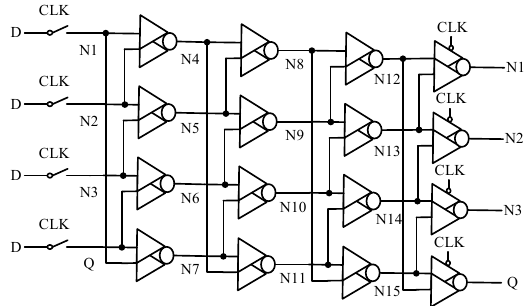
Figure 8. Latch schematic for HTNURL.